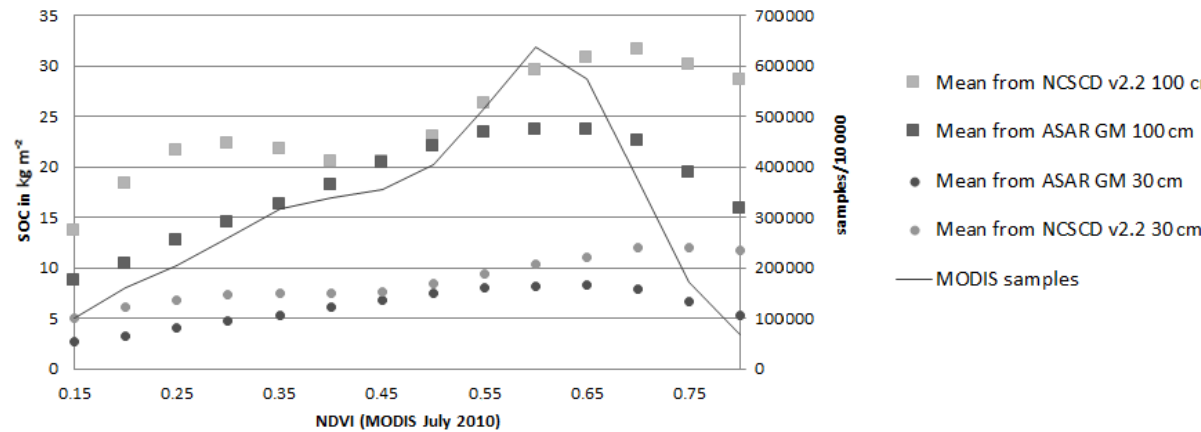
Figure 15. SOC from the GM results as well as the NCSCD in comparison to normalized difference vegetation index (NDVI; source: MODIS). SOC values have been averaged for class increments of 0.05